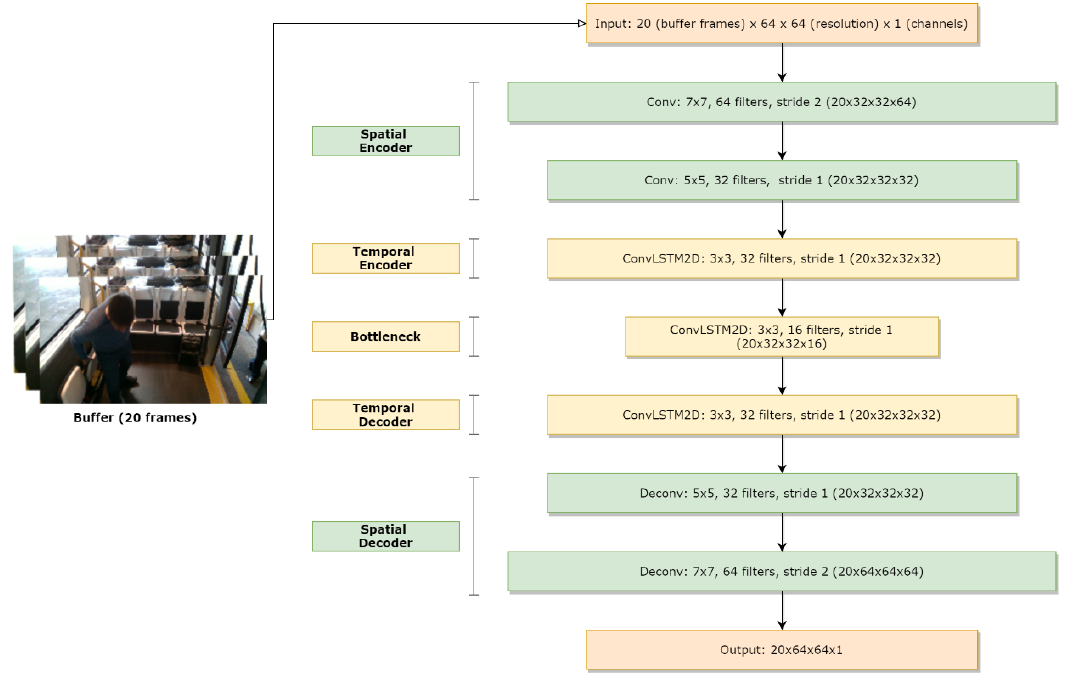
Figure 10. Model architecture of the autoencoder: The first two convolutional layers are spatial encoders, followed by temporal encoder and decoder. Between them, a ConvLSTM with reduced filters is used as a bottleneck to eliminate non useful information. At the last two layers we perform spatial decoding, reconstructing the input image to the same